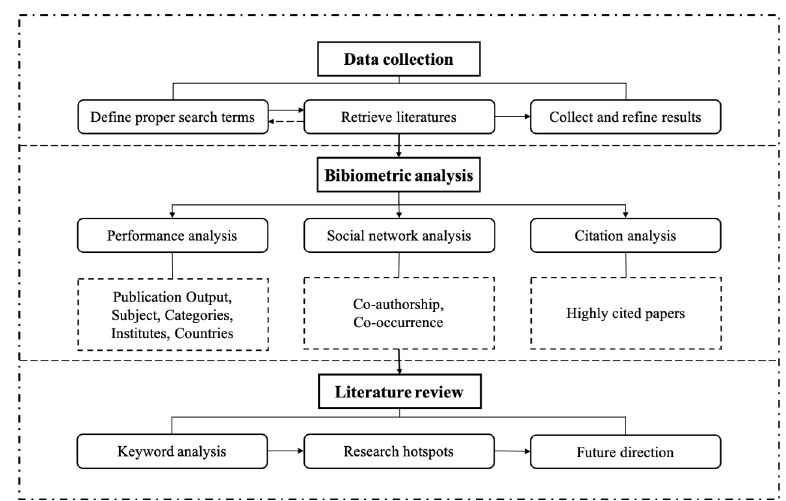
Figure 1. The research framework and procedures implemented in this